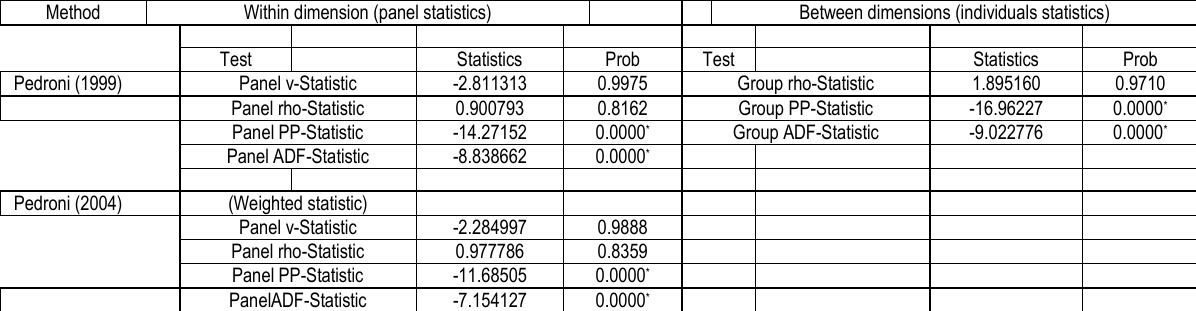
Table 4. Pedroni cointegration